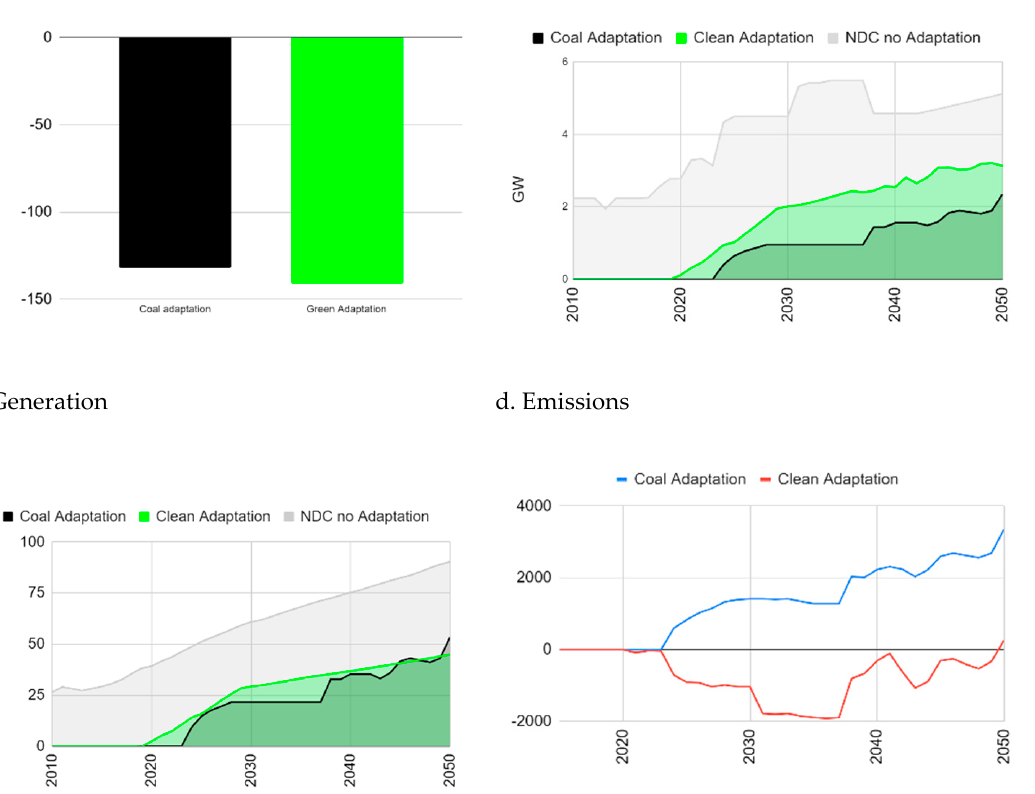
Figure 5. Summary Results—Comparative description of the NDC, Coal Adaptation and Clean Adaptation.